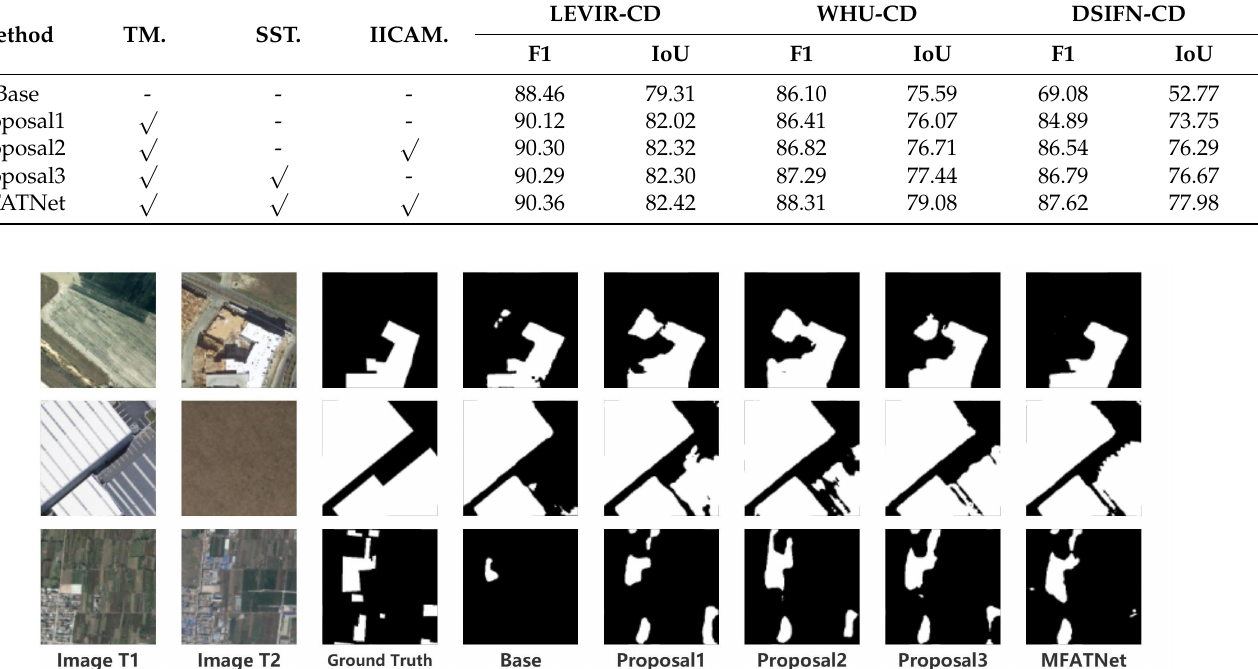
Table 1. Ablation studies of MFATNet on the test sets of LEVIR-CD, WHU-CD, and DSIFN-CD. Method